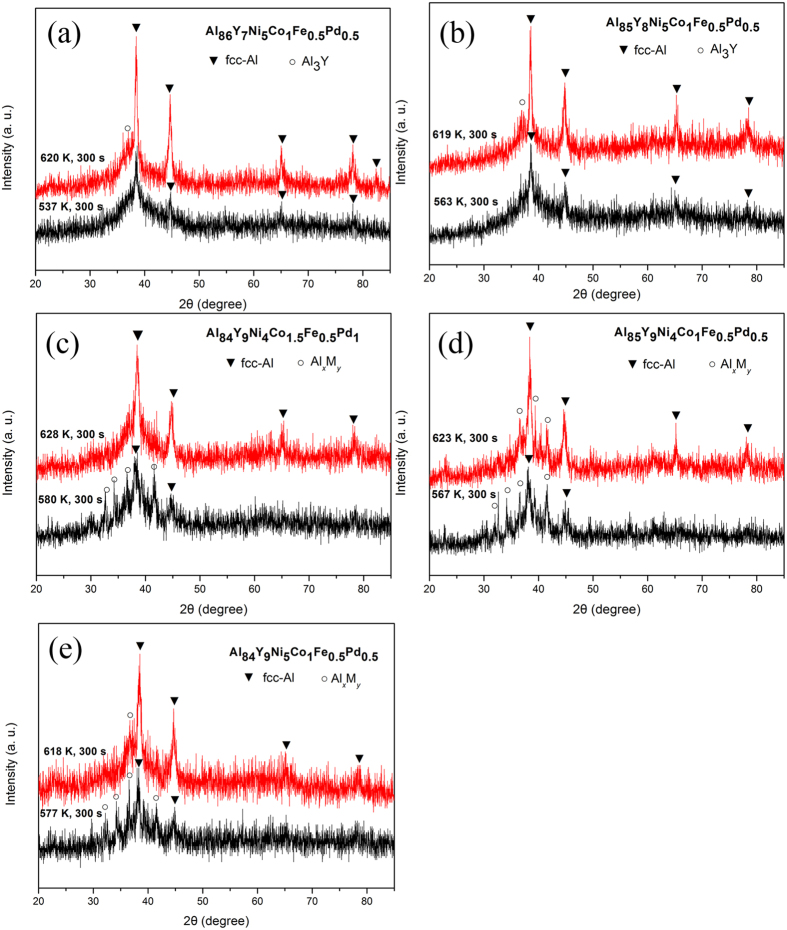
X–ray diffraction patterns of the (a) 86Al, (b) 85Al and (c) 84Al glasses annealed for 300 s at each peak temperature of the first and the second exothermic peaks shown in Fig. 1, (d) Al85Y9Ni4Co1Fe0.5Pd0.5 and (e) Al84Y9Ni5Co1Fe0.5Pd0.5 glasses at each peak temperature of their first and second exothermic peaks.